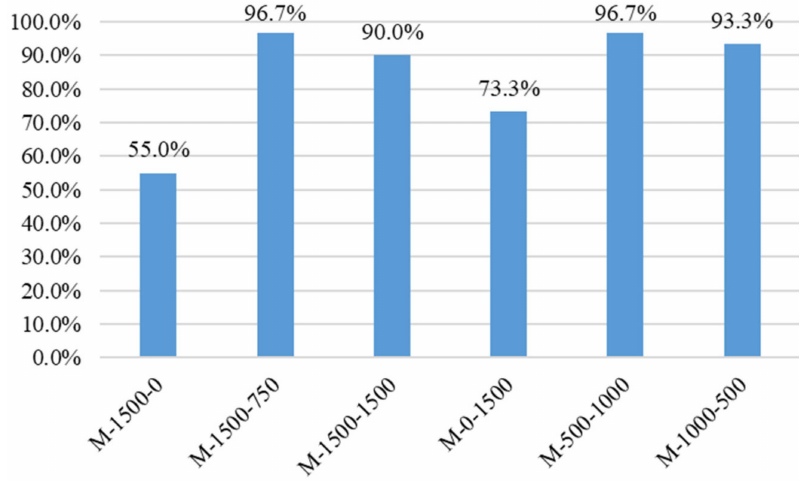
Figure 17. Rebar number recognition accuracy.